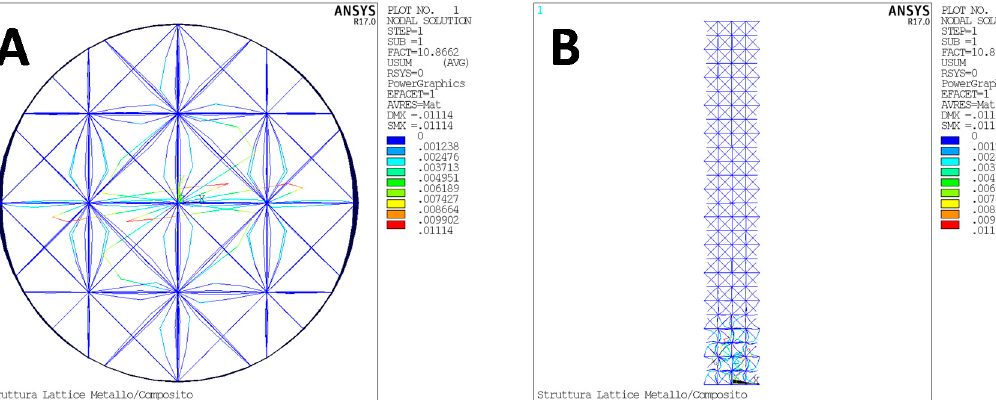
Figure 22. Test case 2—1st buckling mode. Total Displacement: upper view ( A ) and lateral view without skin ( B ). Table 3. Test case 2—Mass budget.